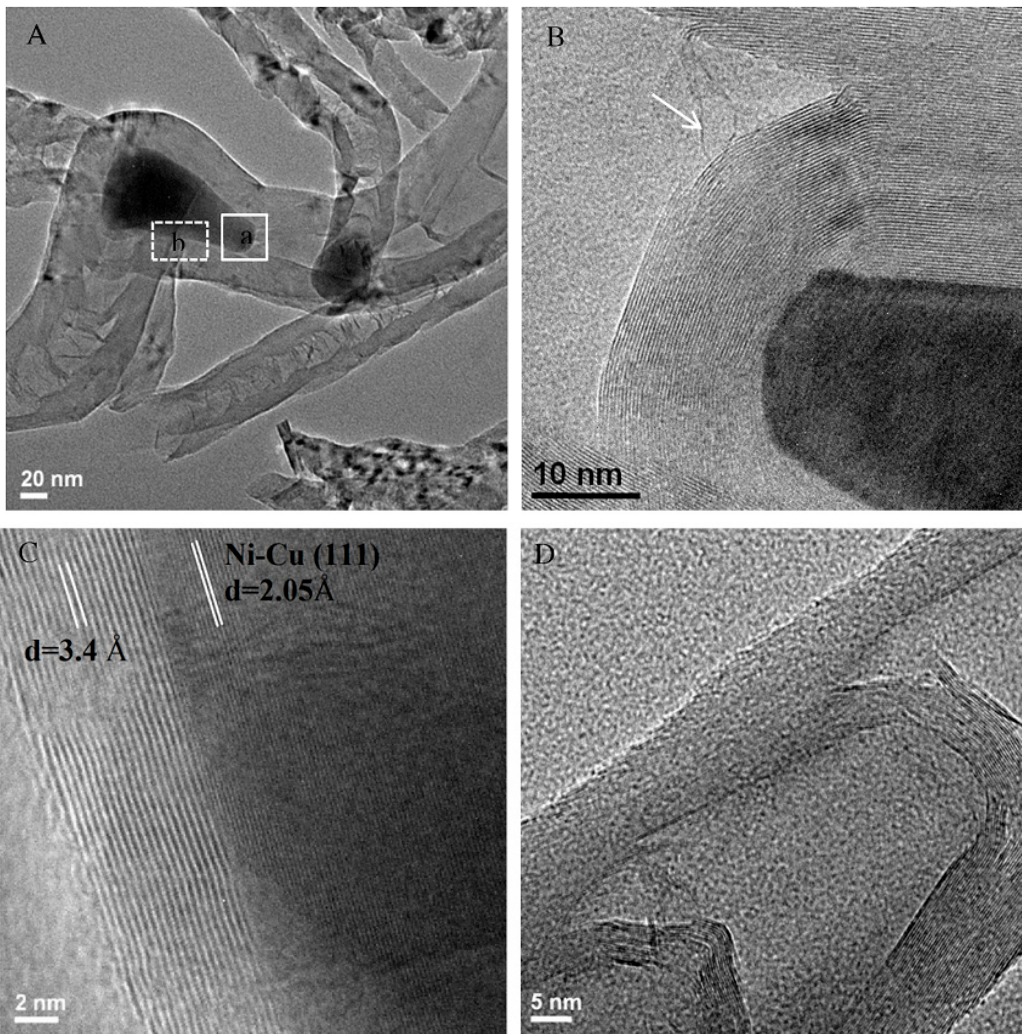
Figure 6. TEM images of the bamboo ‐ like carbon nanofibers (CNFs) on the Ni 47 Cu 53 /CNT catalyst ( A ) bamboo ‐ like CNFs, ( B ) magnification of the region marked “a” in ( A ), ( C ) magnification of the region marked “b” in ( A ) and ( D ) a typical bamboo ‐ like CNF (reprinted with permission from Ref. [59], copyright 2015 Elsevier).